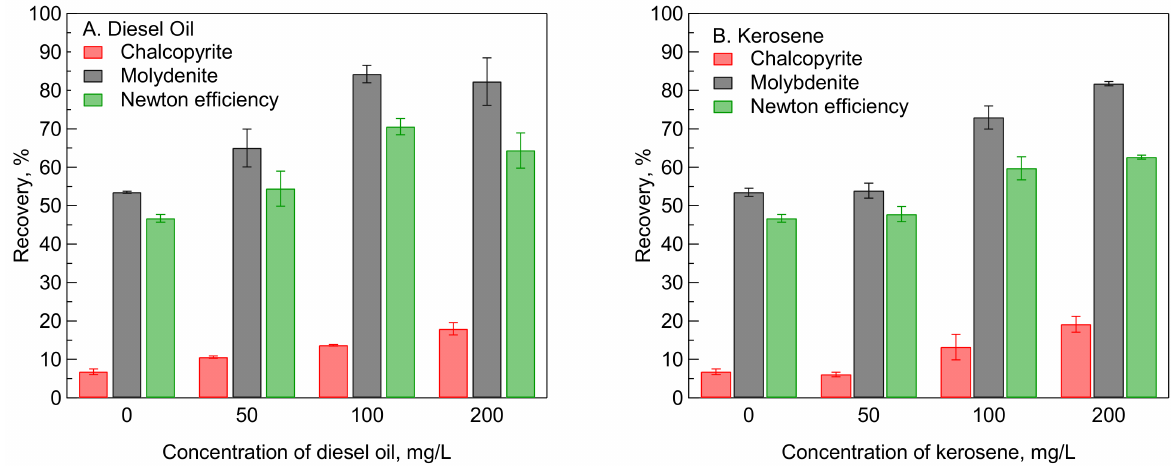
Figure 6. Effect of emulsified diesel oil ( A ) and kerosene ( B ) on the recovery of mixed chalcopyrite and molybdenite after being treated in 1 mM MBS at pH